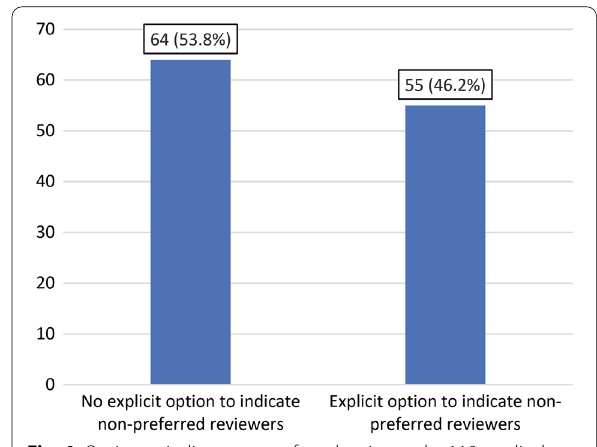
Fig. 4 Option to indicate nonpreferred reviewers by 119 medical imaging journals (absolute numbers with percentages between